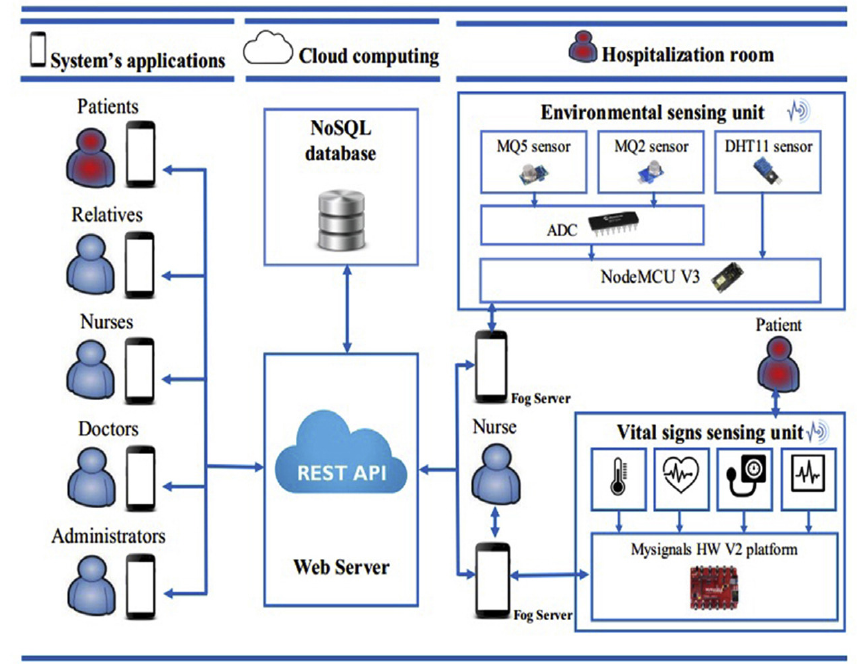
Figure 3. The home hospitalization platform proposed by [75] based on fog computing, which is a highly suitable and efficient system in the context of the COVID-19